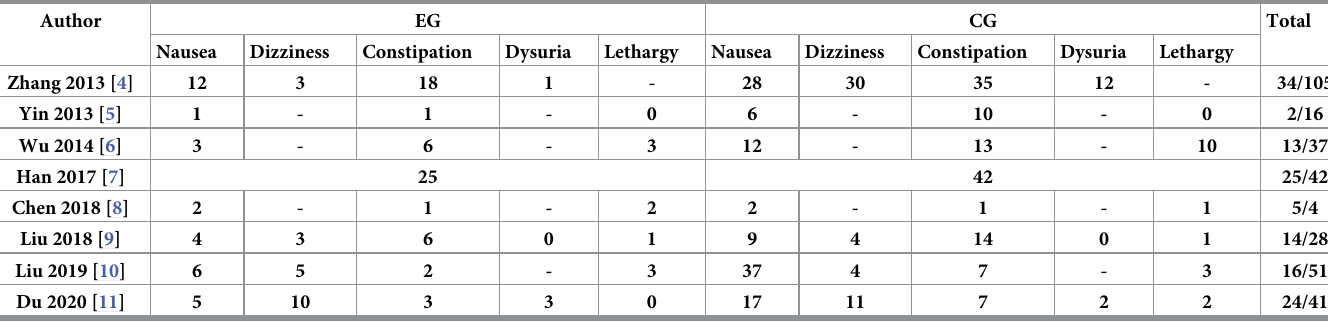
Table 2. Characteristics of the adverse reactions.